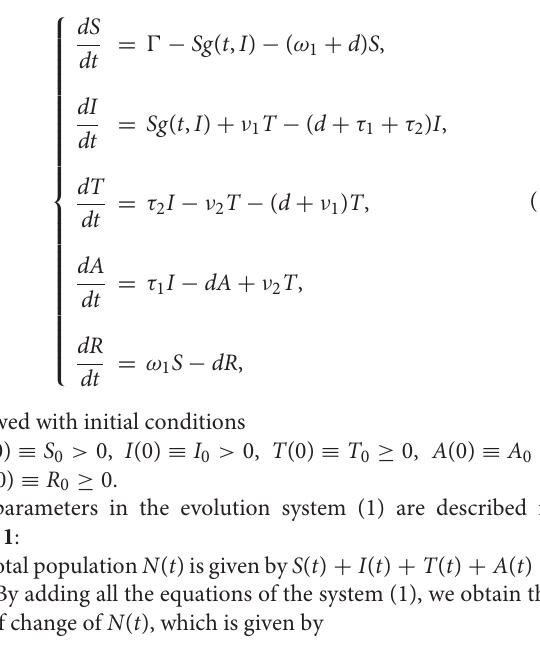
Table 1 : The total population N ( t ) is given by S ( t ) + I ( t ) + T ( t ) + A ( t ) + R ( t ). By adding all the equations of the system (1), we obtain the rate of change of N ( t ), which is given by dN and N ( t ) varies over time and is nearing a stable fixed point t → ∞ . Therefore, the biologically feasible region for the system (1) is given by 9